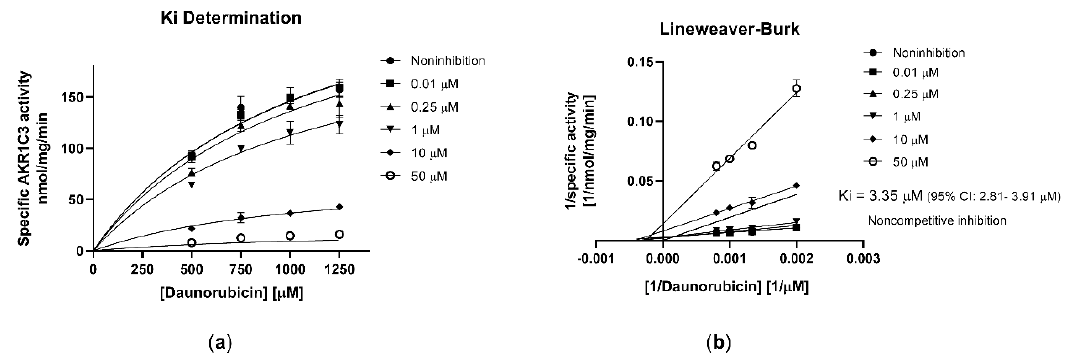
Figure 3. ( a ) Inhibitory constant ( Ki) -value determination. ( b ) Lineweaver–Burk double-reciprocal plot. Data are expressed as the mean ± SD from three independent assays. Measurements were performed using different substrate